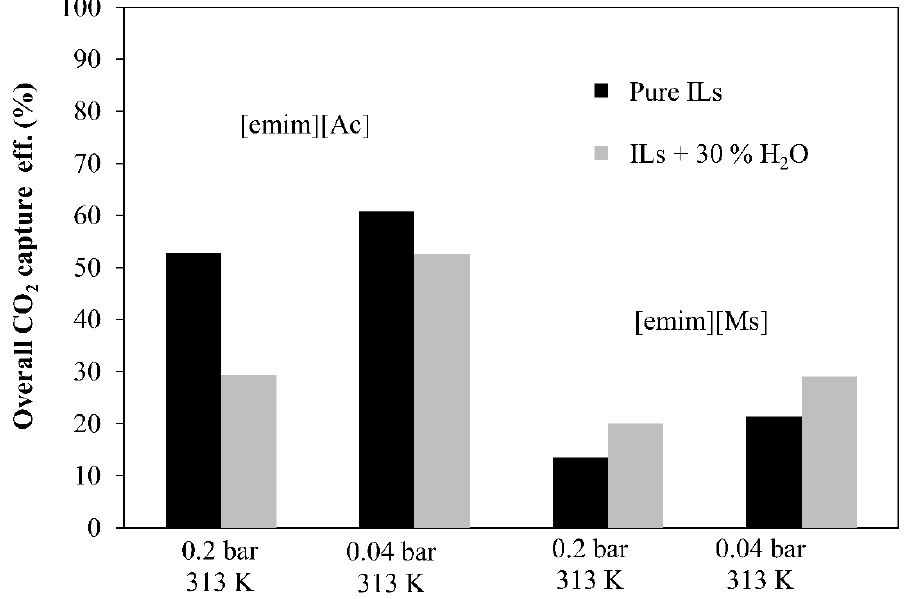
Figure 9. Overall CO 2 capture efficiency at different desorption vacuum pressures using both pure ILs and aqueous ILs. Commercial HFMC operational conditions: temperature 313 K, liquid flow rate 60 mL·min − 1 .